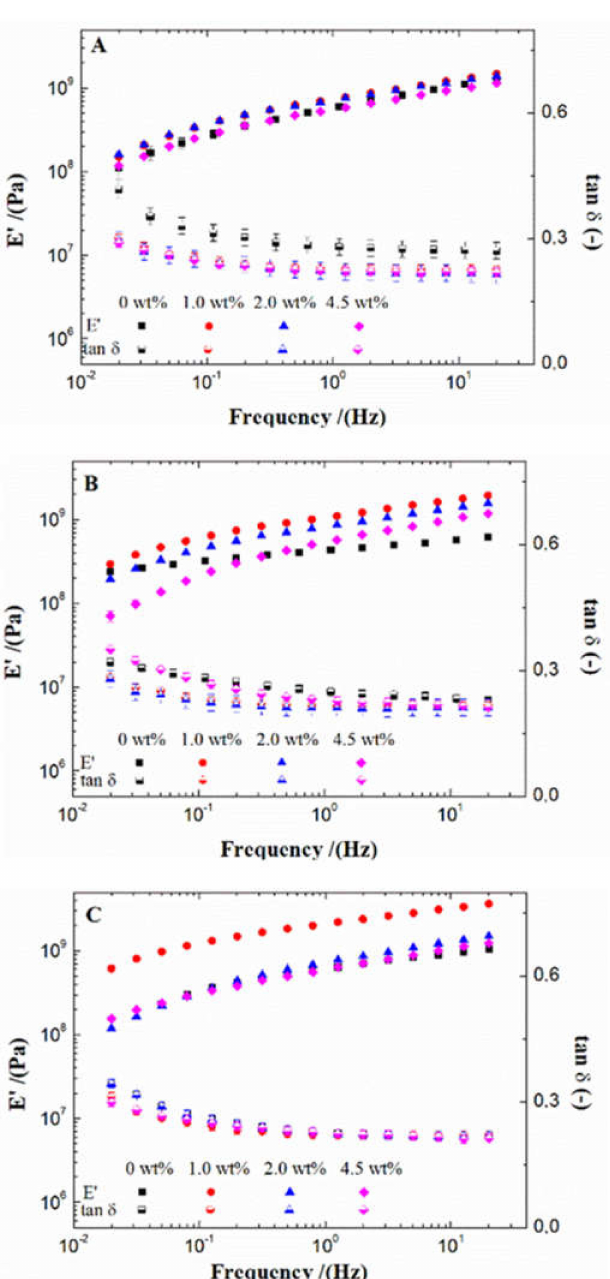
Figure 1. Flexural properties of bioplastics with different ZnO nanoparticle concentrations (0 wt%, 1.0 wt%, 2.0 wt% and 4.5 wt%) processed at different mould temperatures: 70 ◦ C ( A ), 90 ◦ C ( B ) and 110 ◦ C ( C ). Elastic modulus (E’) and loss tangent (tan δ ) profile in frequency